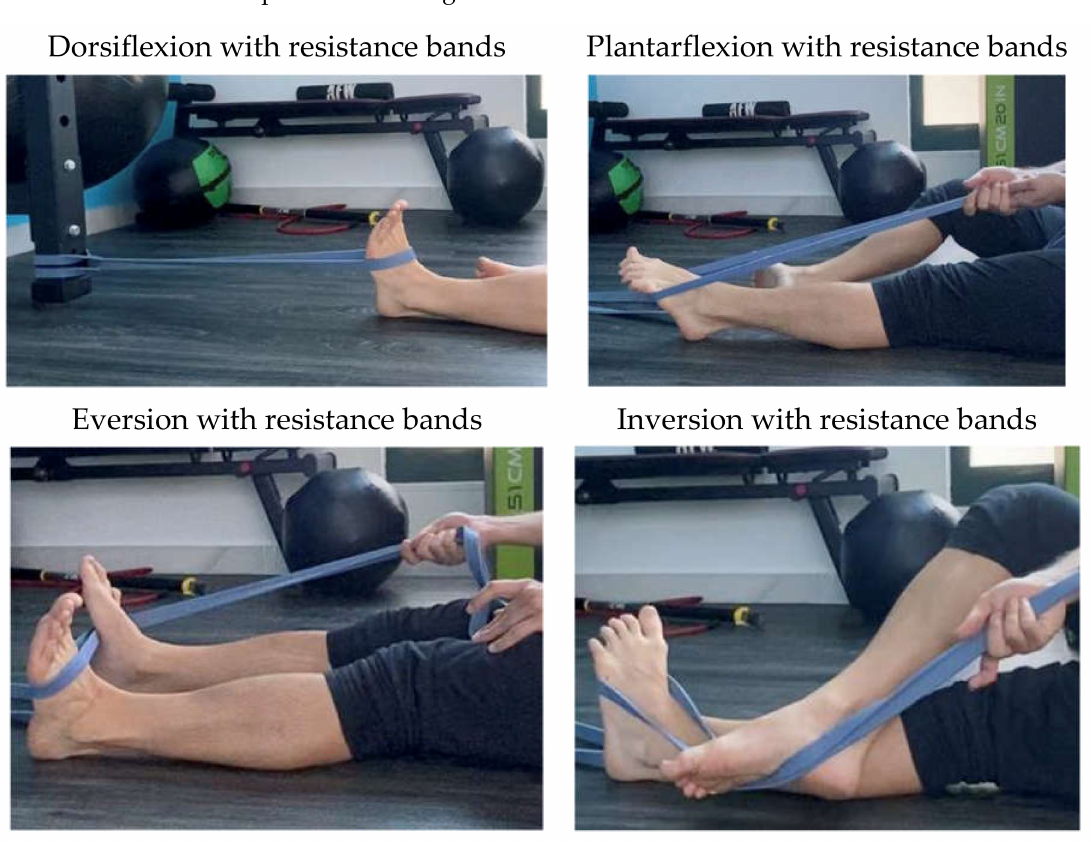
Figure 2. Strength training